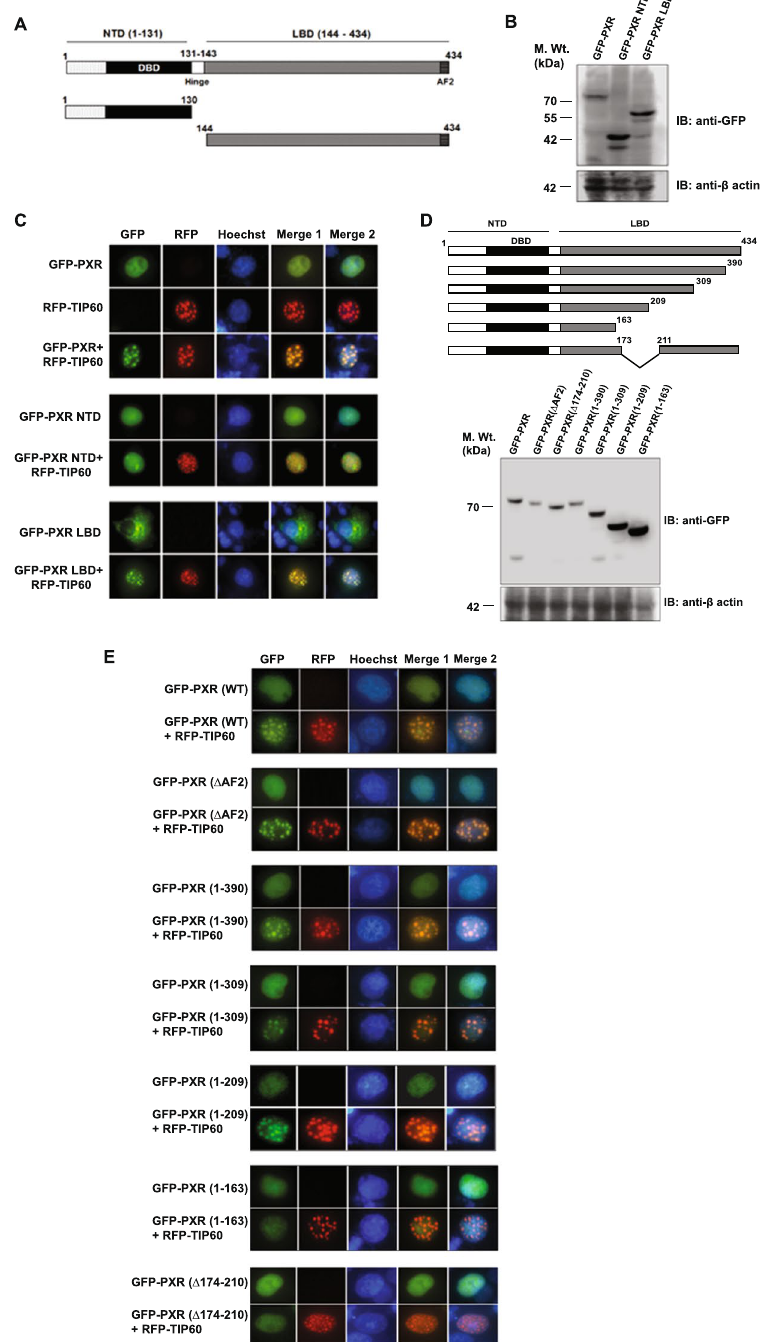
Figure 2. 174–210 region of PXR LBD is required for its interaction with TIP60. ( A ) Schematic representation of full-length PXR and its domain-wise deletion constructs. ( B ) Western blot showing expression of full- length PXR and its deletion constructs cloned into GFP vector. ( C ) Cos-1 cells were transfected with GFP- PXR or its deletion constructs alone and in combination with RFP-TIP60 as indicated in the figure and their intracellular localization was monitored by fluorescence imaging. ( D ) Schematic representation of a series of full-length PXR C-terminal deletion constructs. Western blot analysis was performed using anti-GFP antibody to detect expression of PXR LBD deletion constructs. ( E ) GFP-PXR or its deletion constructs as indicated were transfected alone or with RFP-TIP60 in Cos-1 cells and subcellular localization of tagged proteins were monitored by live cell imaging. Full-length immunoblots are presented in Supplementary Figure